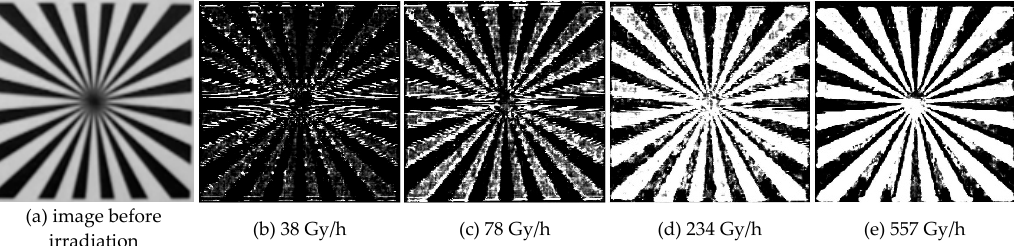
Figure 6. Comparison of radiation responses in black and white background regions at irradiation dose rates of 0, 38, 78, 234, and 557 Gy/h. Upon the overlapping of the grayscale value of 2000 frames, an obvious difference in the radiation response between the black and the white background regions was observed; the boundary was more obvious at a larger irradiation dose rate. The radiation response events generated in the white regions required irradiation at a higher dose rate.